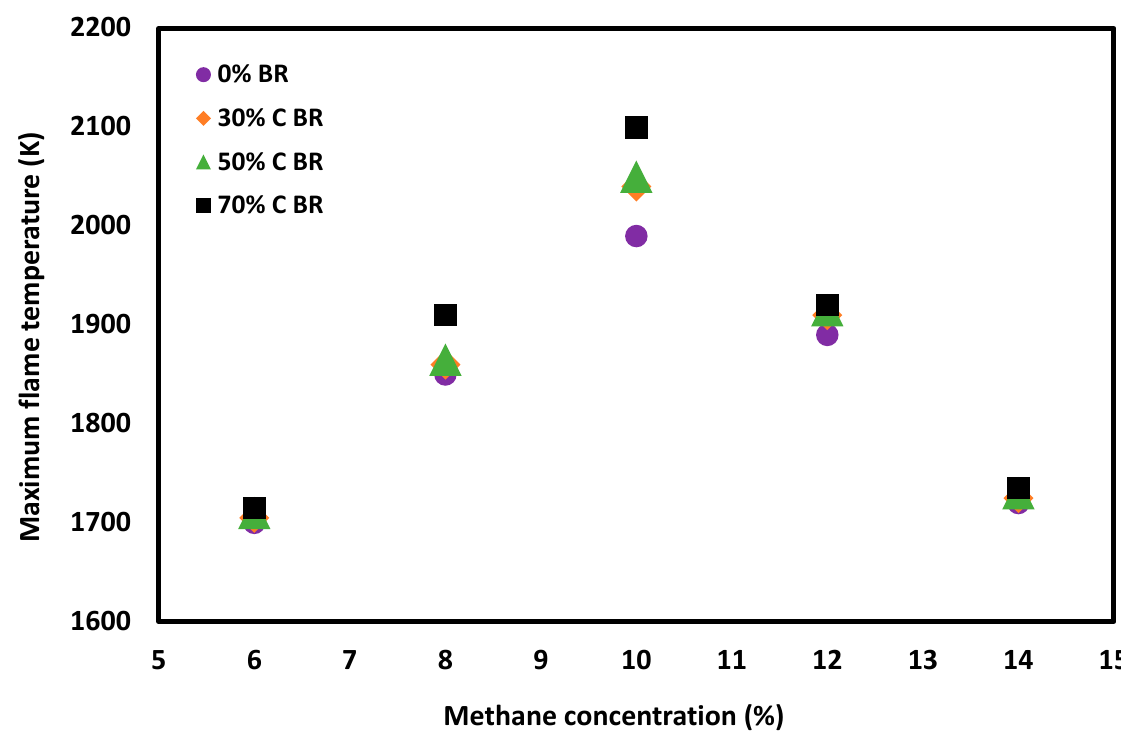
Figure 7. Flame temperature as a function of methane concentration in the straight tube and when the tube included 30%, 50% or 70% orifice plates placed 1.2 and 2.4 m from the ignition source.